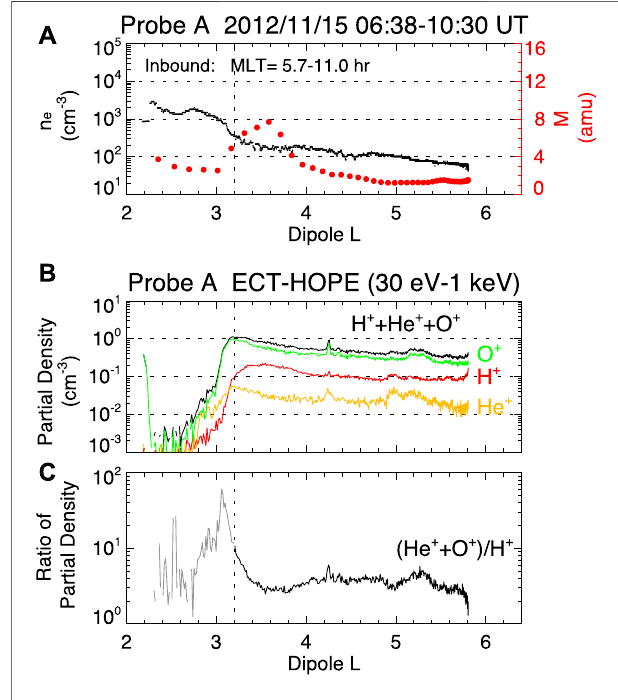
FIGURE 8 | Localized heavy ion density enhancement reported in an RBSPstudy(afterNosé etal.,2015). (A) L pro fi leoftheelectron density (black curve)andtheaverageionmass(reddots). (B) NumberdensityoftheH + ,He + , and O + ions obtained by taking the moment of ion fl uxes measured by the HOPE instrument in the energy range 30 eV – 1 keV. (C) Number density ratio between the heavy ions (He + and O + ) and H + , calculated using the data shown in panel (B) .